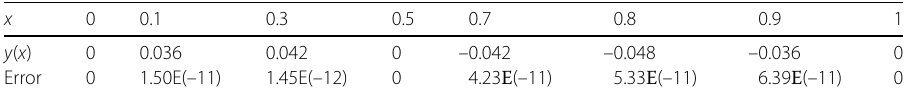
Table 2 For Example 3, showing the numerical solutions and the absolute errors obtained by the BSFM at different